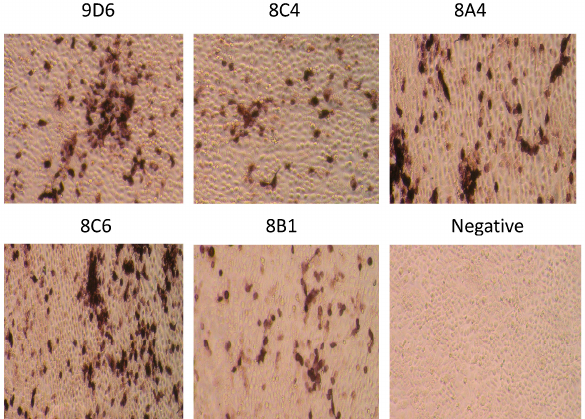
Figure 3. Detection of hemagglutination (HA) protein from A/Swine/Guangdong/LM/2004 (SW/GD/04) infected MDCK cells with mAbs 9D6, 8C4, 8A4, 8C6, and 8B1 by immunohistochemistry (IH). Non-infected MDCK cells are used as a negative control. Magnification: 400×.